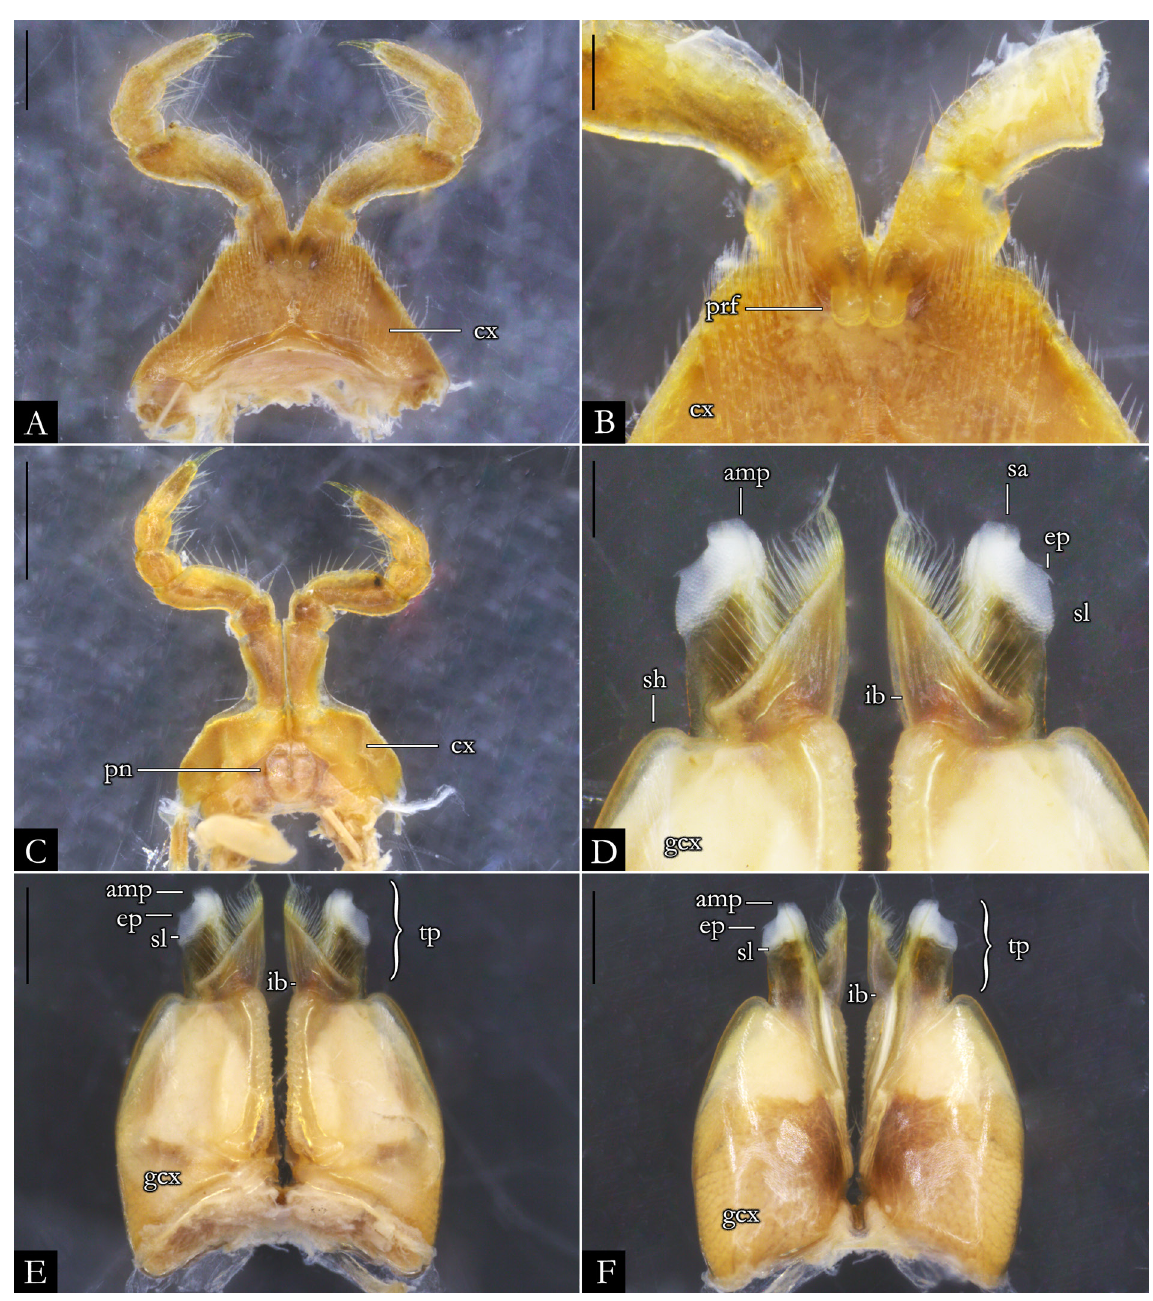
Fig. 59. Pseudonannolene callipyge Brölemann, 1902, ♂ (IBSP 7615). A . First leg-pair. B . Detail of prefemur. C . Second leg-pair. D . Detail of telopodites, in anal view. E . Gonopods, in anal view. F . Gonopods, in oral view. Abbreviations: see Material and methods. Scale bars: A, E–F = 0.5 mm; B, D = 0.2 mm; C = 1